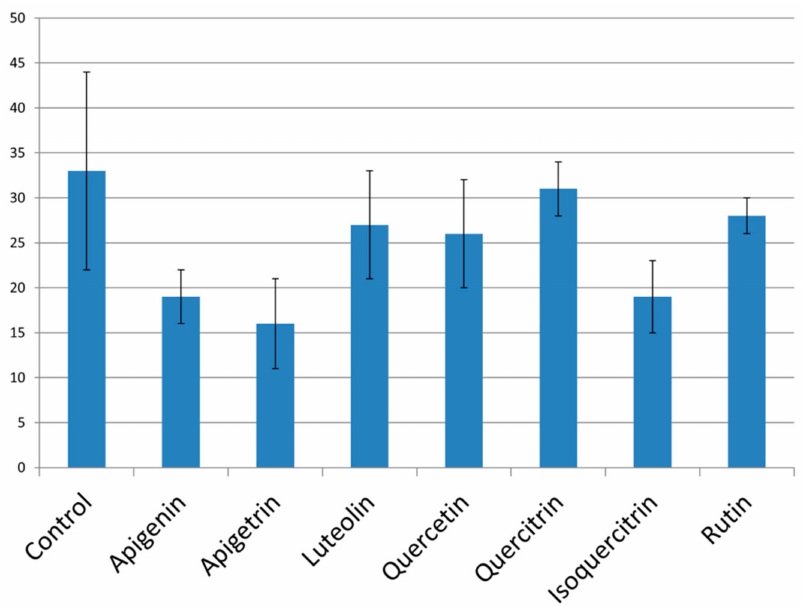
Figure 2. Percentage of hyphal cells calculated by comparison with the total number of C. albicans cells. Values are means ± SD of three